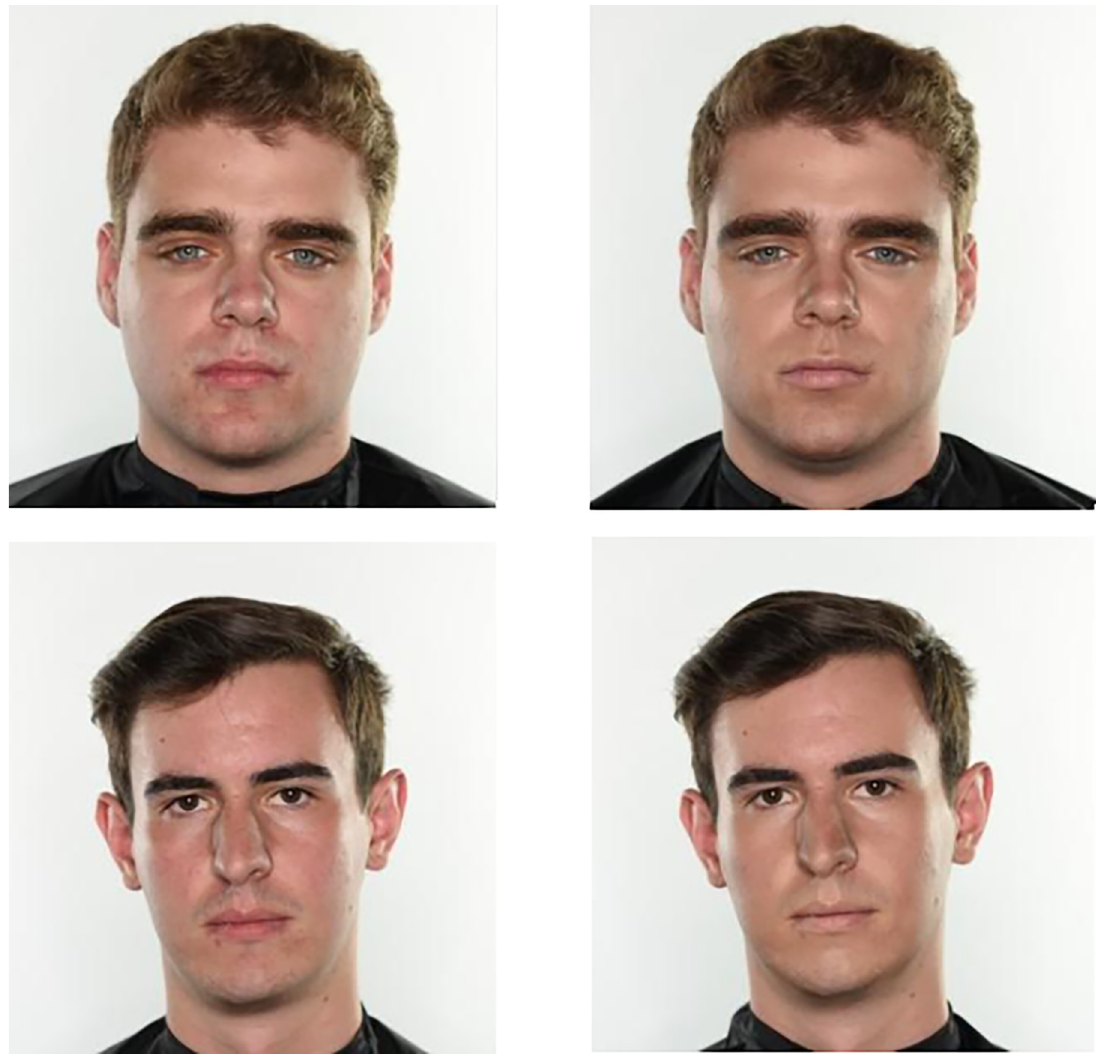
Fig 1. Example stimuli. Two of the participants without cosmetics (left) and with cosmetics applied by a professional makeup artist